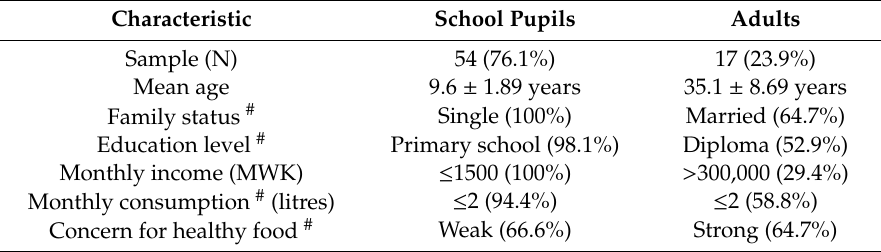
Table 2. Sociodemographic profiles of the baobab juice consumer segments in